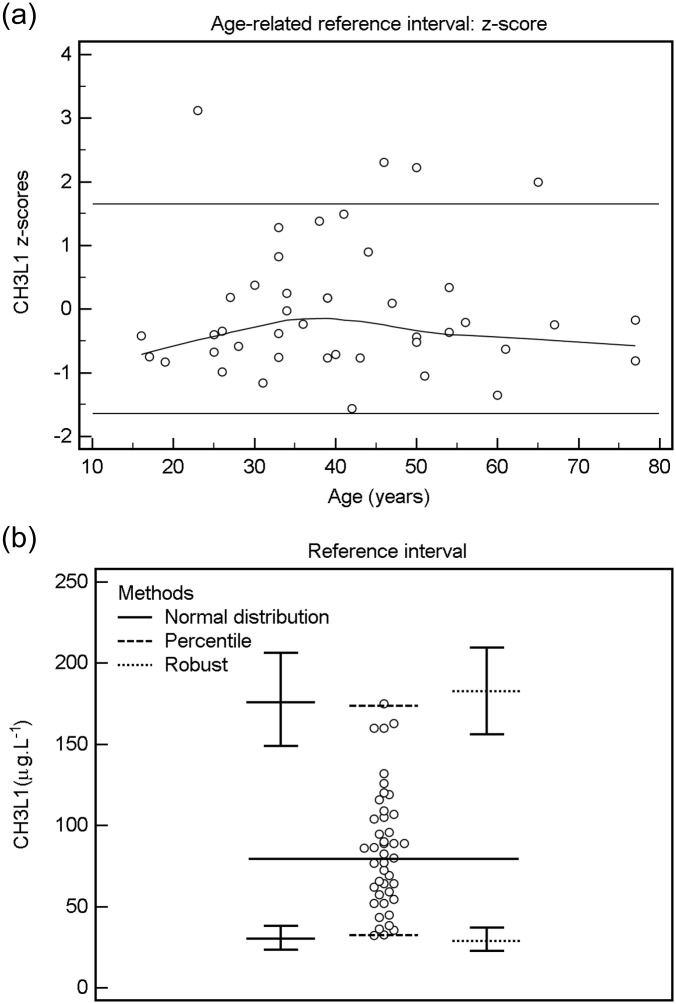
Estimation of the CHI3L1 CSF reference interval and age-dependence of test values.A: Age-related reference interval: centiles; B: reference interval.